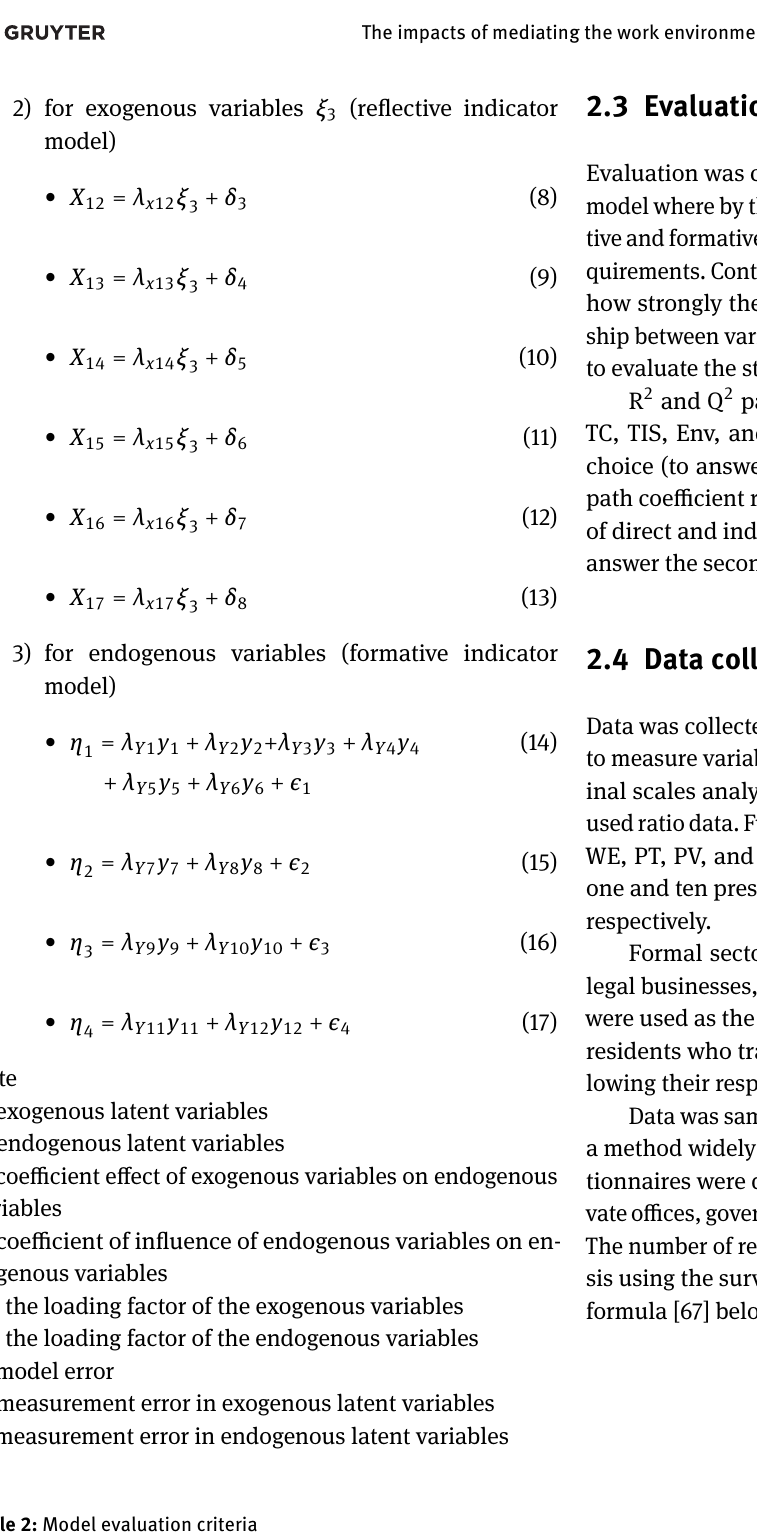
Table 2: Model evaluation criteria Model Evaluation